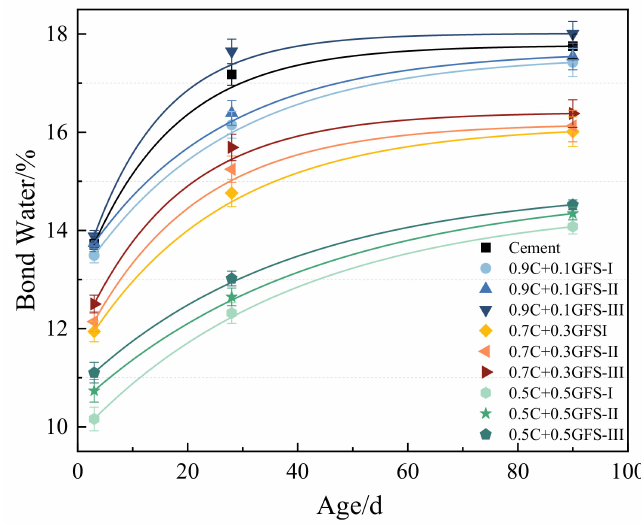
Figure 11. The chemically-bound water content of the blended